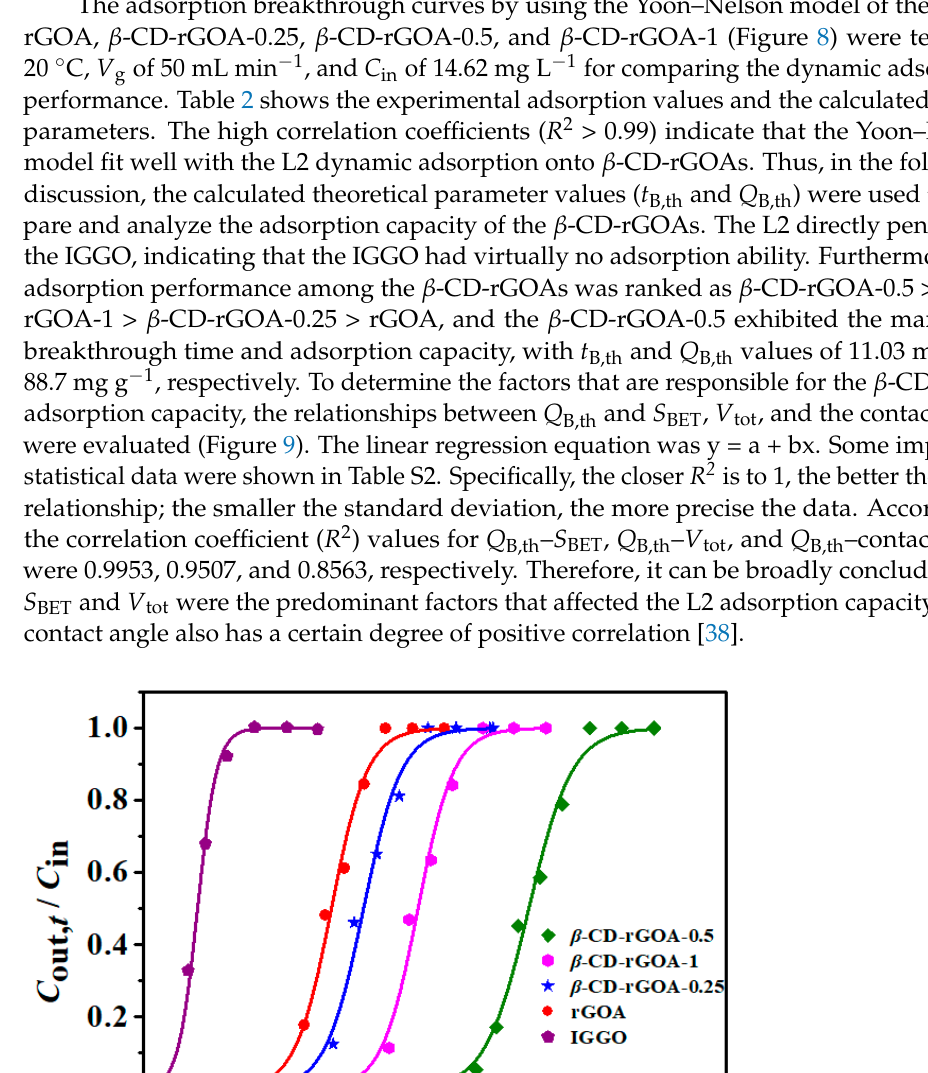
9 of 14 Figure 7. Working mechanism of hydrothermal reduction and crosslinking. 3.3. Comparison of Dynamic Adsorption Performances